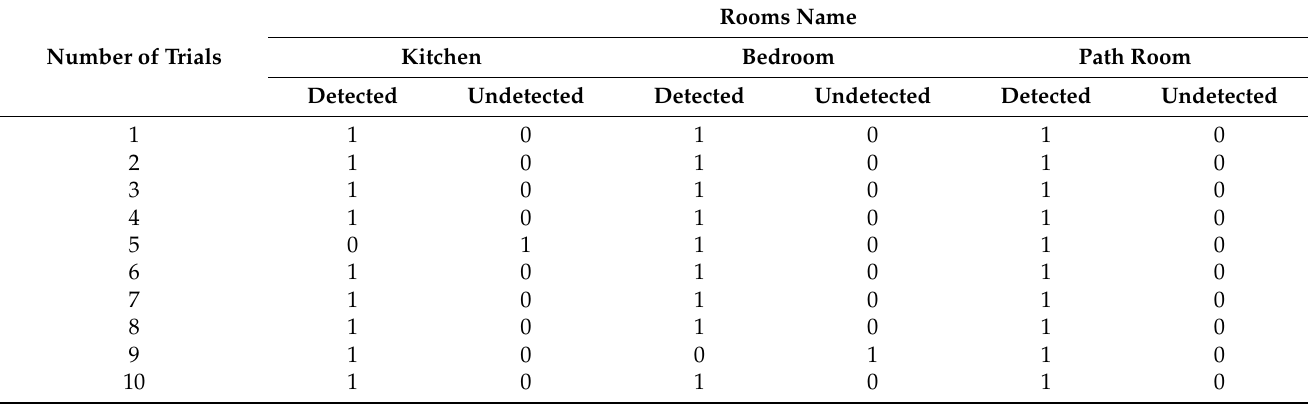
Table 2. Detection ratio of the ultrasonic sensor (human